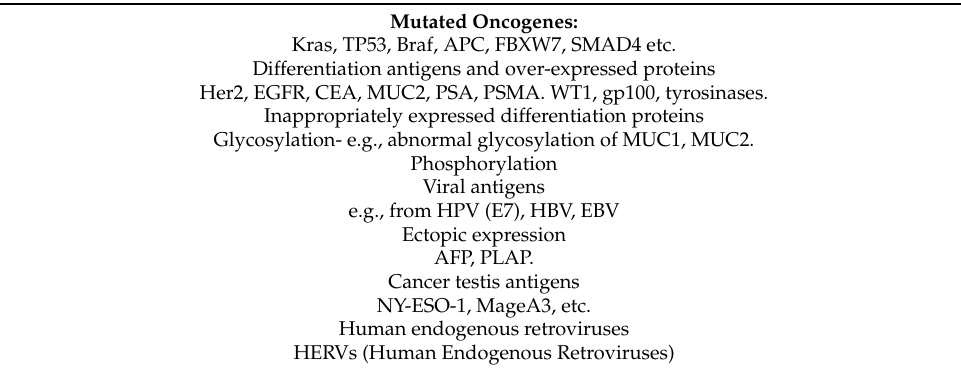
Table 2. Tumor antigen targets for T cell-mediated